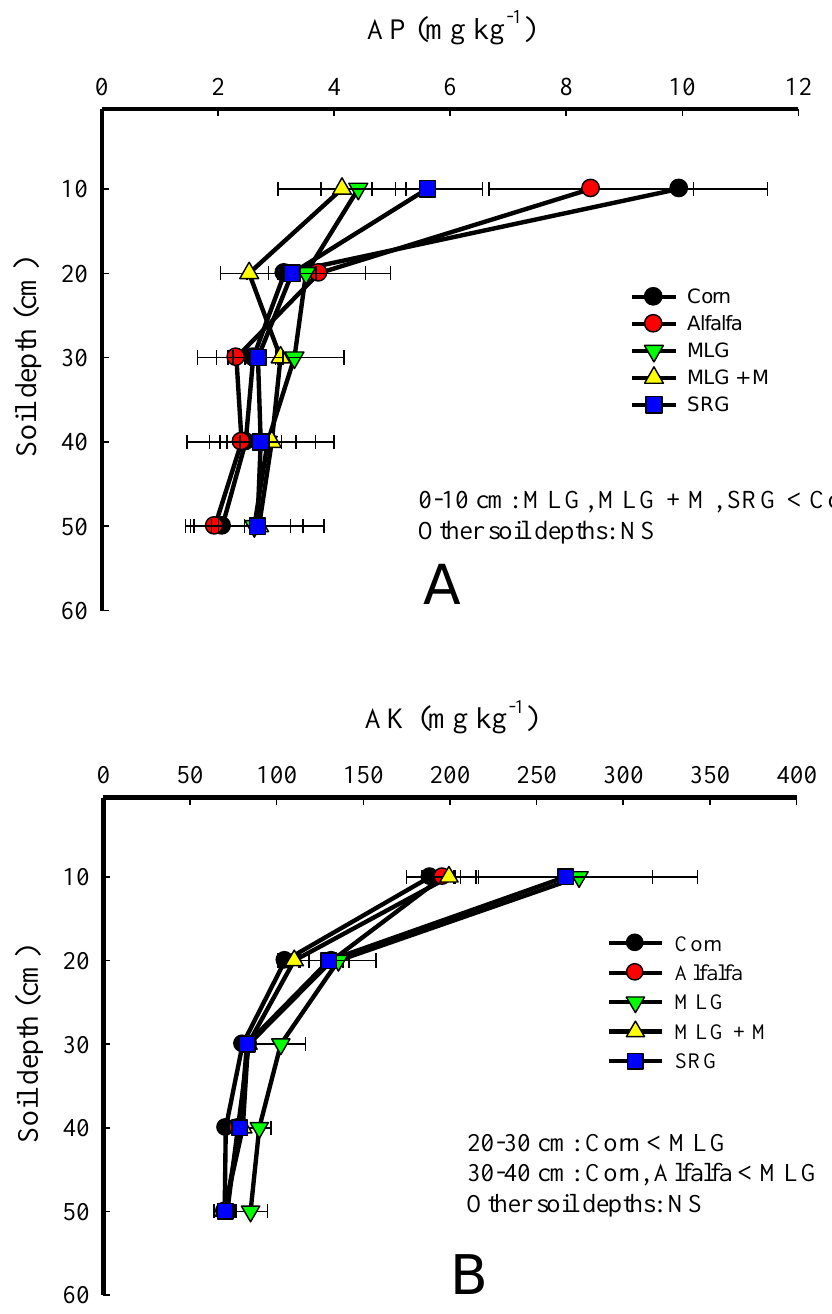
Figure 5. Mean values of AP ( A ) and AK ( B ) under different land uses. AP represents available phosphorus. AK represents available potassium. The bars represent standard errors. NS = not significant among different land uses.